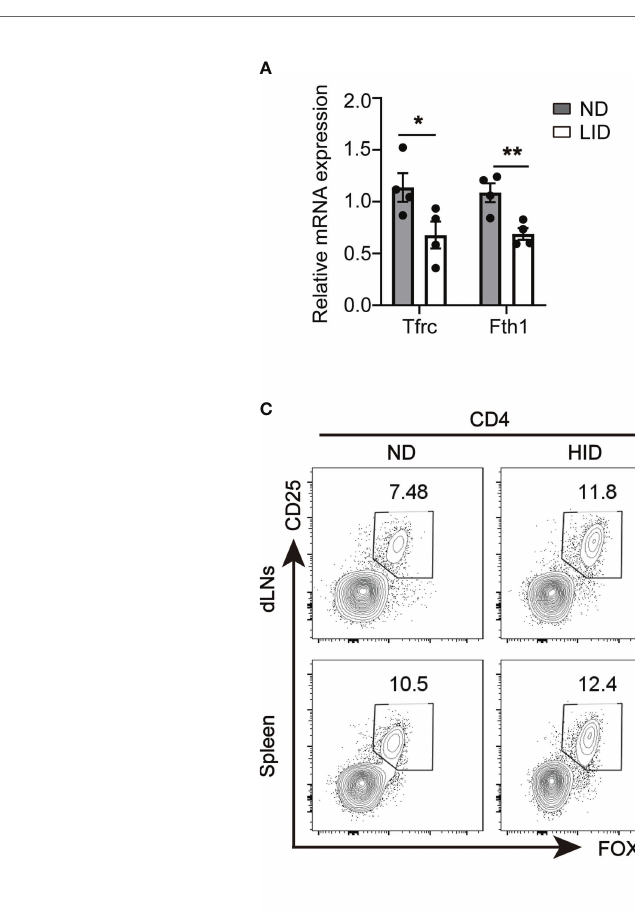
FIGURE 1 | Insuf fi cient iron contributes to Treg cell expansion. 3-weeks old female C57 mice were fed with ND or LID for 5 weeks and then were sacri fi ced for analysis. (A, B) qPCR of iron-related gene Tfrc and Fth1 (A) and Treg cell-related gene Il2r and Foxp3 (B) in splenic CD4 + T cells of ND- and LID-treated mice. (C) Representative fl ow cytometry of Treg cells gated on CD4 + T cells in dLNs and spleen of ND- and LID-treated mice. (D, E) quanti fi cation of the percentage and numbers of Treg cells in (C). **P < 0.01, *P < 0.05 (unpaired two-tailed Student ’ s t -test for A , B , D , E ). Data are shown as mean ± S.E.M. Two independent experiments were performed, n =